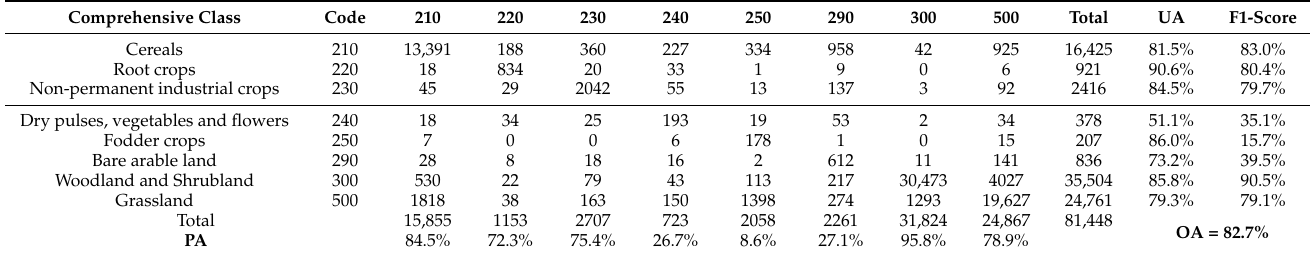
Table 7. Confusion matrix for comprehensive classes by applying a trained model (using RF classifier) on the validation dataset utilizing S1DS2Y feature set. UA = User Accuracy, PA = Producer’s Accuracy, OA = Overall